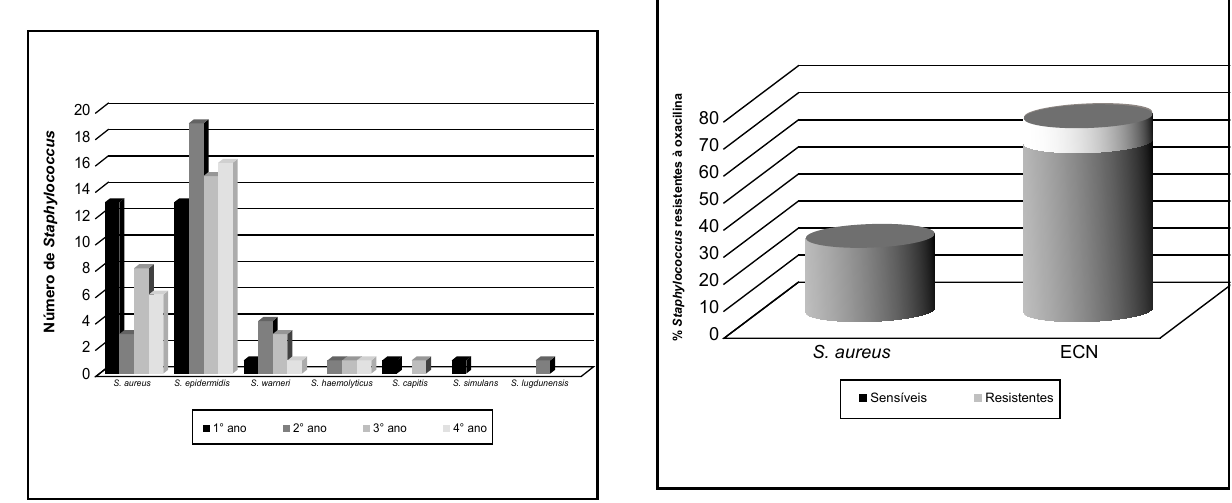
Figura 1 – Distribuição de S. aureus e espécies de ECN isoladas das fossas nasais de alunos do primeiro ao quarto ano do curso de enfermagem da FMB ECN: estafilococos coagulase-negativos; FMB: Faculdade de Medicina de Botucatu.